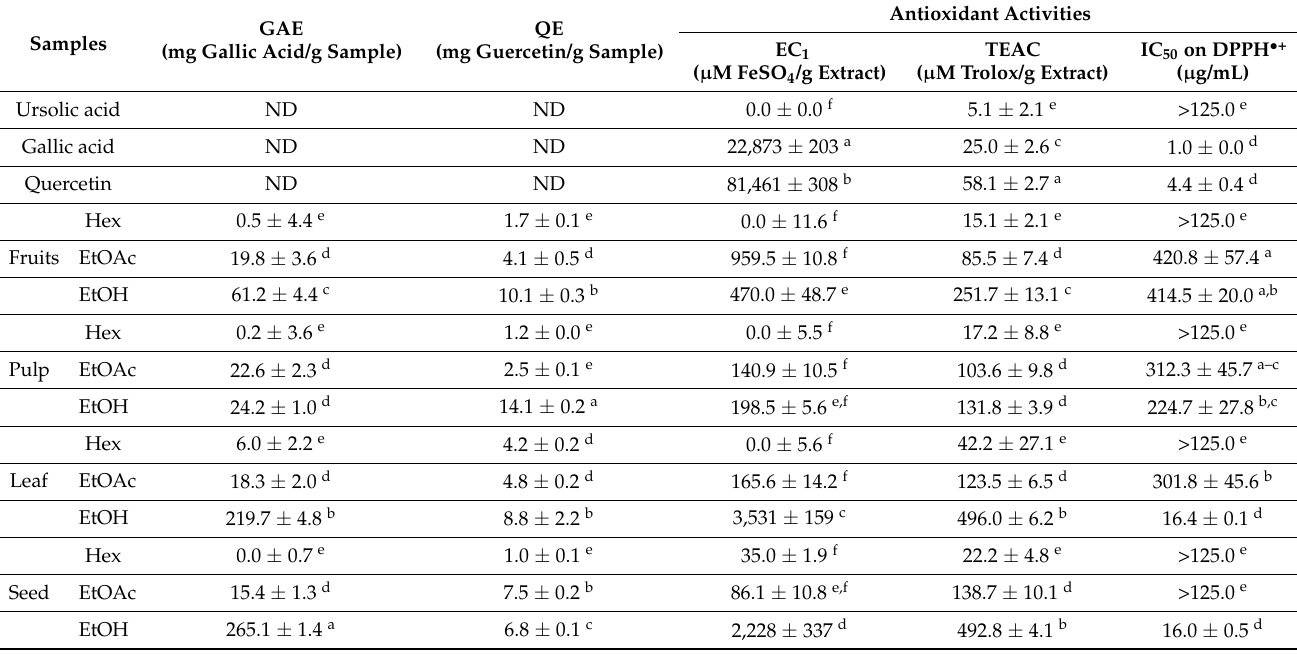
Table 1. Total phenolics content, total flavonoids content, and antioxidant activities of each C. carandas extracts.